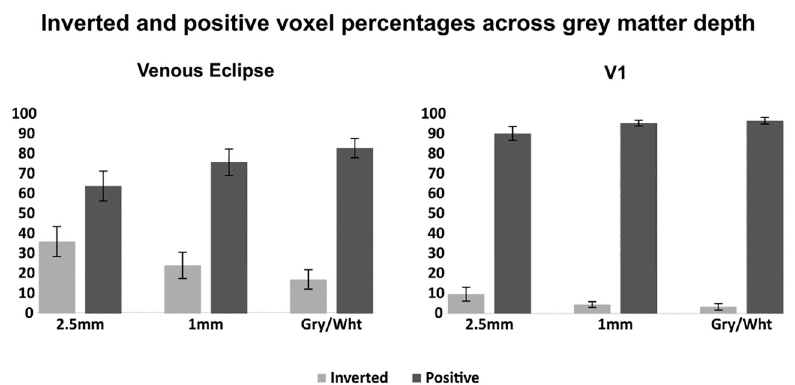
Fig 15. Average percentage of inverted and positive voxels in the venous eclipse and V1 for the left and right hemispheres of Subjects 5 and 6. A reduction in the mean percentages of inverted voxels within both regions is apparent with progression away from the cortical surface and toward the grey/white boundary. The venous eclipse has higher percentages of inverted voxels at every surface level compared to V1. Error bars represent +-1 SD.